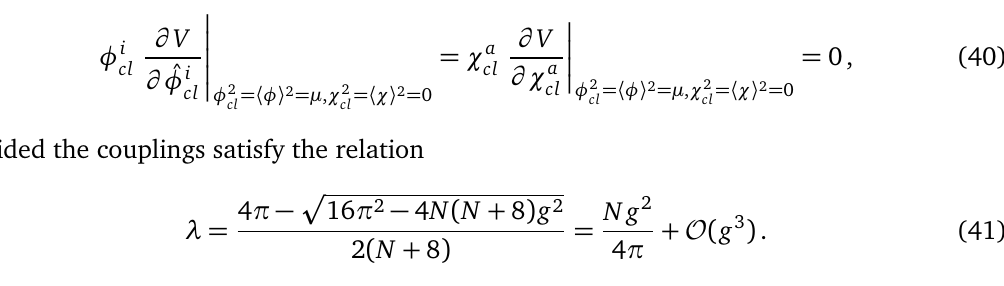
and one of χ . We can see that the potential cl cl -axis. The two-dimensional plots are slices of the cl = 0 or χ = 0. In the plots g = 0.01 and µ = cl cl